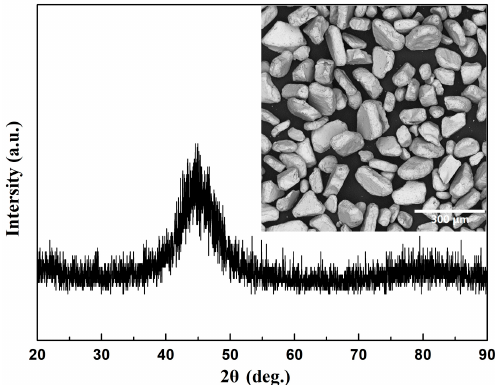
Figure 1. X-ray diffraction (XRD) patterns of the ball-milling-crushed Fe 78 Si 9 B 13 amorphous powders, the inset shows the scanning electron microscope (SEM) micrograph of the powders